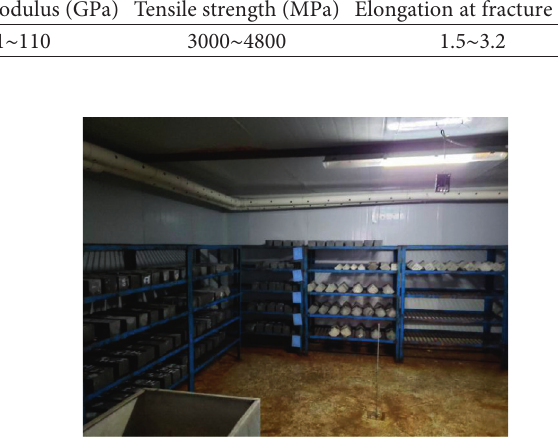
Figure 5: Standard